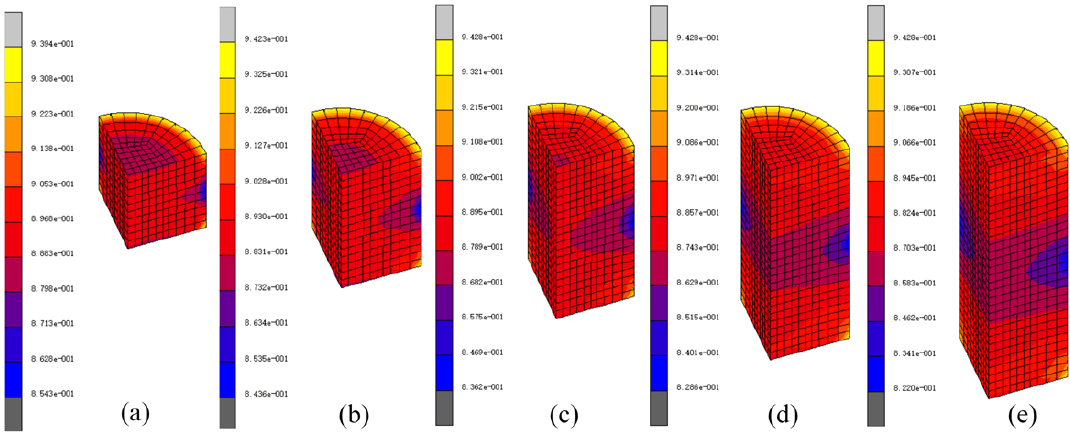
Figure 26. Relative density distributions in compact at the compaction pressure of 200 MPa for various height–diameter (H/D) ratios of ( a ) H/D = 0.7, ( b ) H/D = 1, ( c ) H/D = 1.4, ( d ) H/D = 1.8, and ( e ) H/D = 2.1